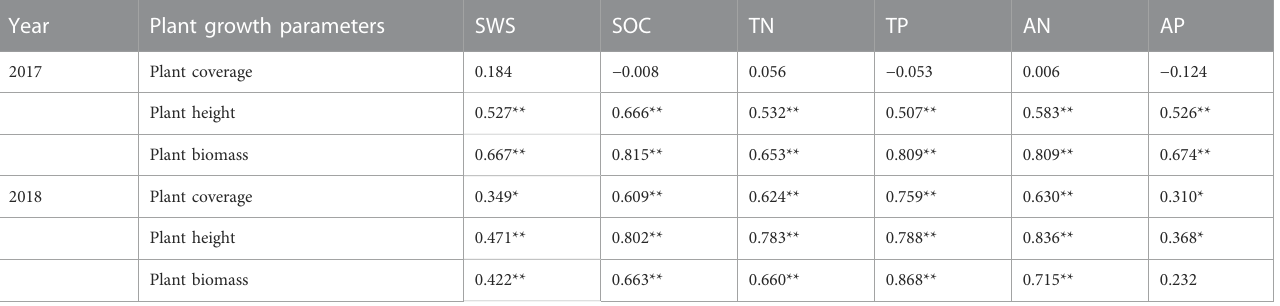
TABLE 2 The correlations between plant growth parameters and soil